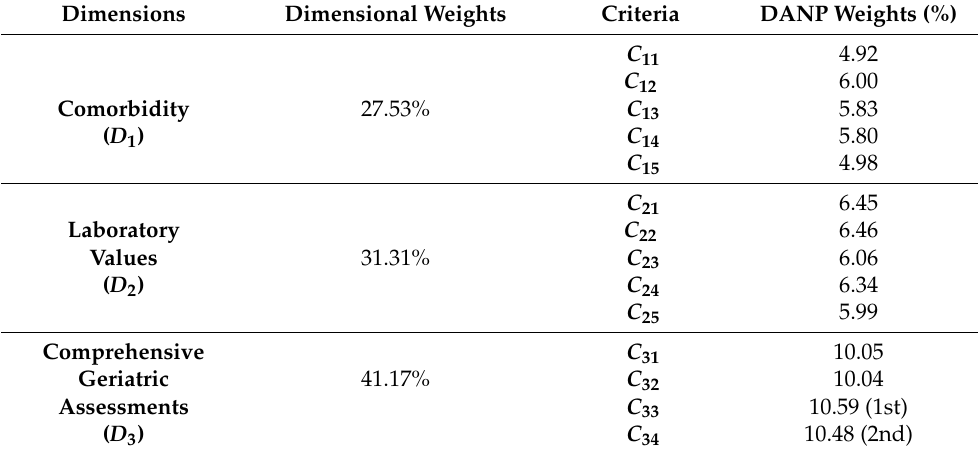
Table 6. DANP (DEMATEL-based Analytical Network Process) influential weights for the AKI risk assessment model for elderly